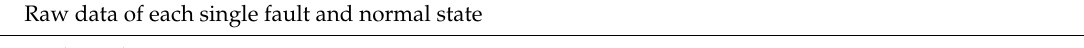
Table 3. The core pseudo code of the diagnosis strategy.